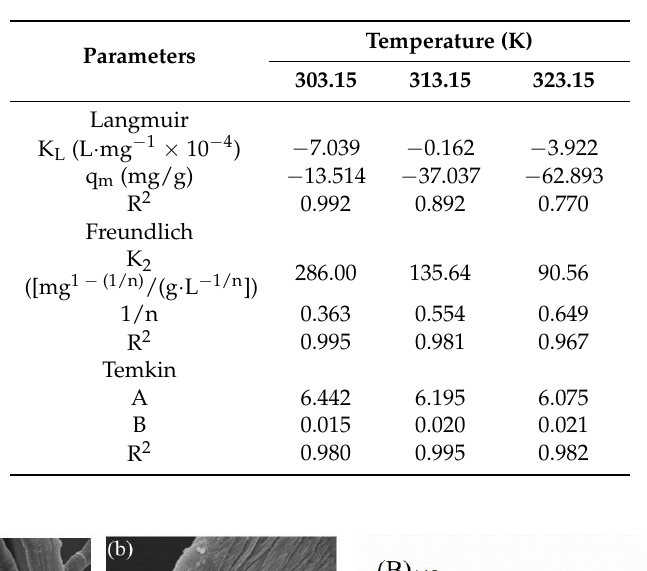
Figure 5. Fitting curves of ( a ) Langmuir; ( b ) Freundlich; and ( c ) Temkin isotherms. Table 2. Isotherm parameters of the adsorption BTB onto QCF.